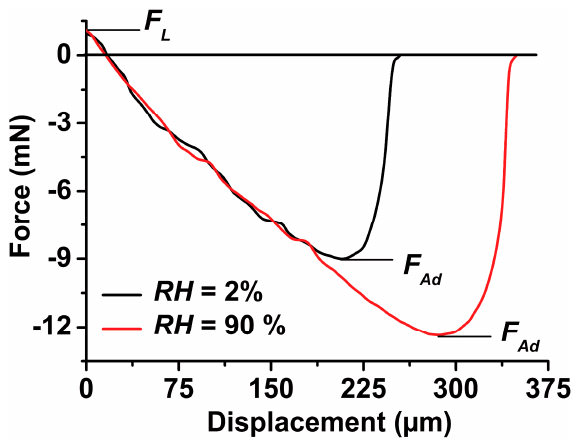
Figure 4. Retraction parts of force-displacement curves obtained on a flat nanoporous PS- b -P2VP monolith at RH = 2% (black curve) and at RH = 90% (red curve). Retraction started immediately after a pre-set loading force F L of 1 mN ± 0.1 mN had been reached.